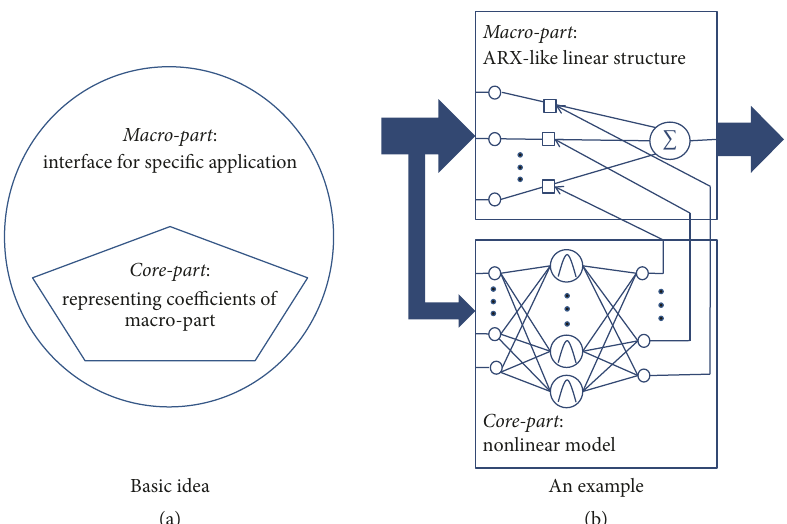
Figure 1: Quasi-ARX modeling. Basic idea of the quasi-ARX modeling is shown in (a), where a macro-part and a core-part are included in the constructed model. An example is illustrated in (b). An ARX-like linear structure works as macro-part for specific application, whose coefficients are parameterized by a flexible RBFN